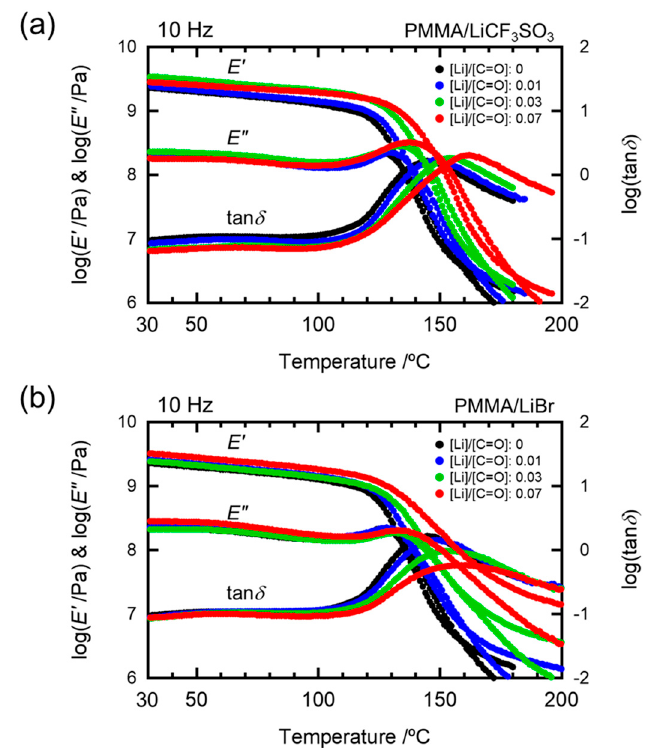
Figure 4. Temperature dependences of dynamic mechanical spectra for ( a ) PMMA/LiCF 3 SO 3 and ( b ) PMMA/LiBr.